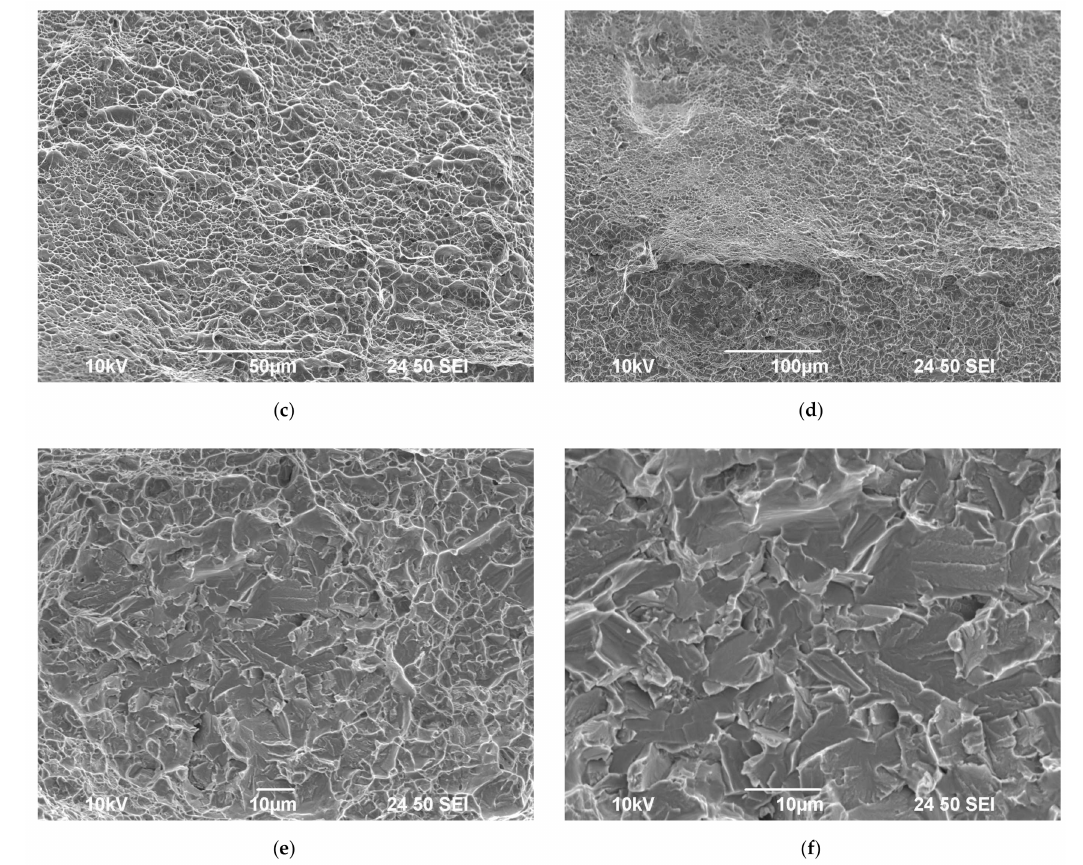
Figure 7. SEM images of the fracture zones analysis of the fractures of the Ti5Al2V alloy specimens after the tension tests: ( a ) general view of a fracture; ( b ) zone of arising and slow propagation of a crack marked by “1” in ( a ); ( c ) zone of rapid propagation of the cracks marked by “2” in ( a ); ( d ) failure zone marked by “3” in ( a ); ( e , f ) fractographic of defect fracture marked by “4” in ( a